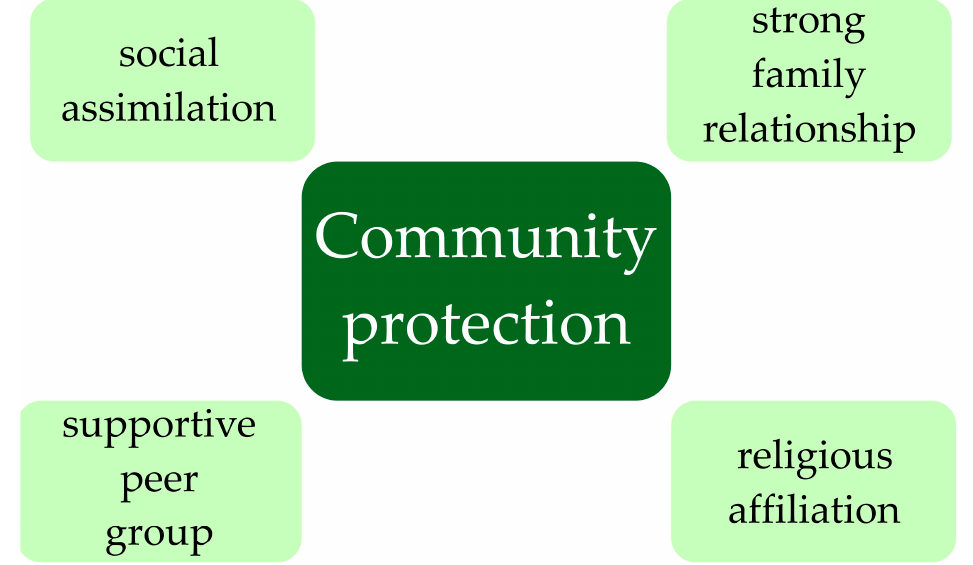
Figure 1. Form of community protection for suicide behaviors of youth.